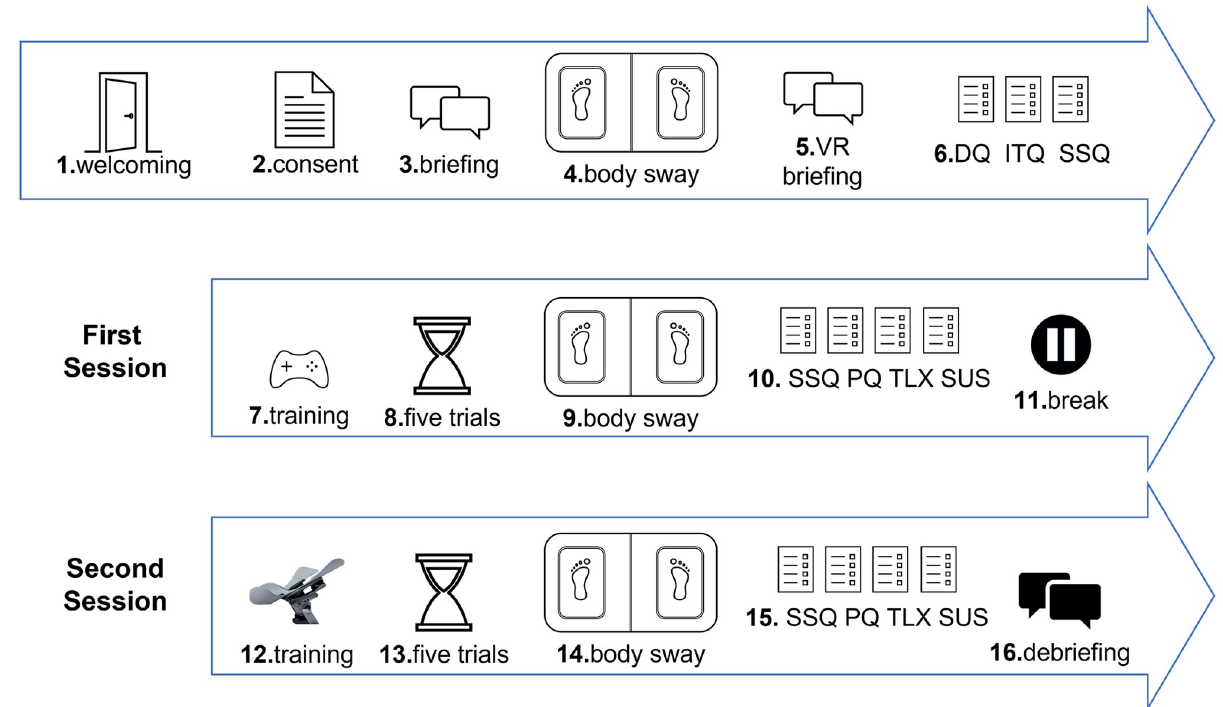
Fig 4. Sixteen steps of the procedure for Experiments 1 and 2. The first six steps included informed consent, baseline measurements for body sway and the questionnaires, and a general introduction to VR. The next five steps included training and testing for one of the control interfaces, and the final five steps included training and testing for the other control interface. The order of control interfaces was counterbalanced across participants.